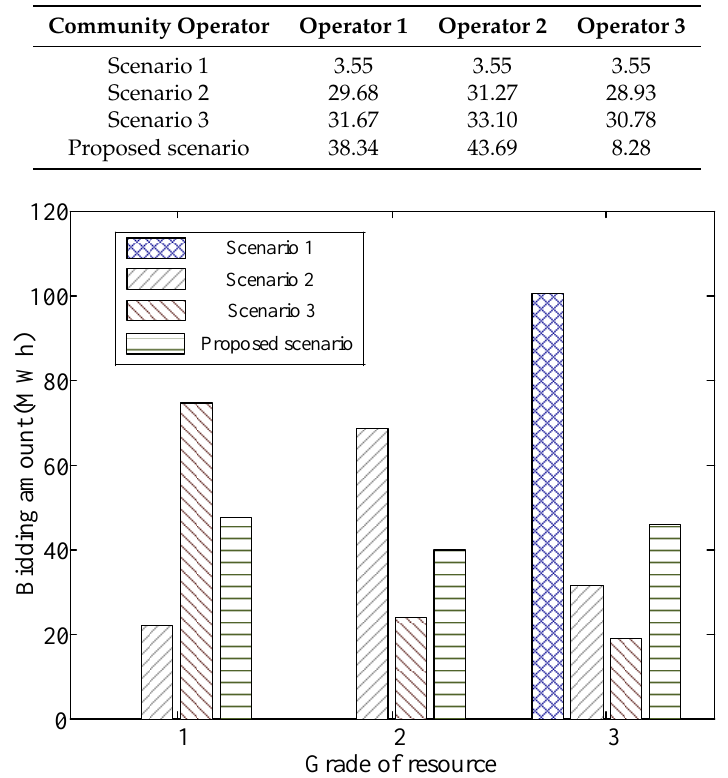
Figure 6. Bidding amount of 3 grades of DR resource for different scenarios.